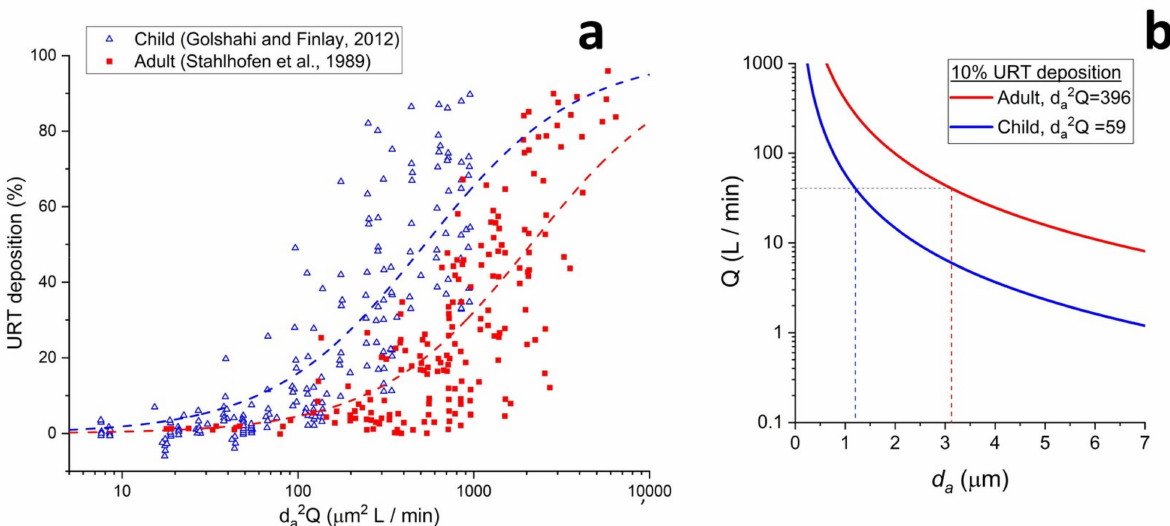
Figure 3. In vitro anatomical throat models. ( a ) Plot of URT deposition versus impaction parameter for child, and adult [9,13]. ( b ) Combination of flow rate and aerodynamic diameter that provide 10% URT deposition in adult and child throat